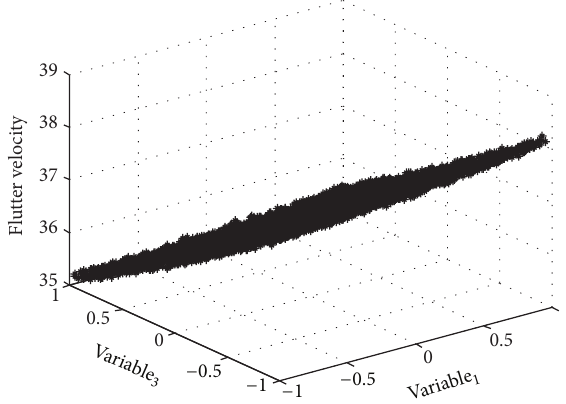
Figure 3: The statistic distribution of flutter velocity.